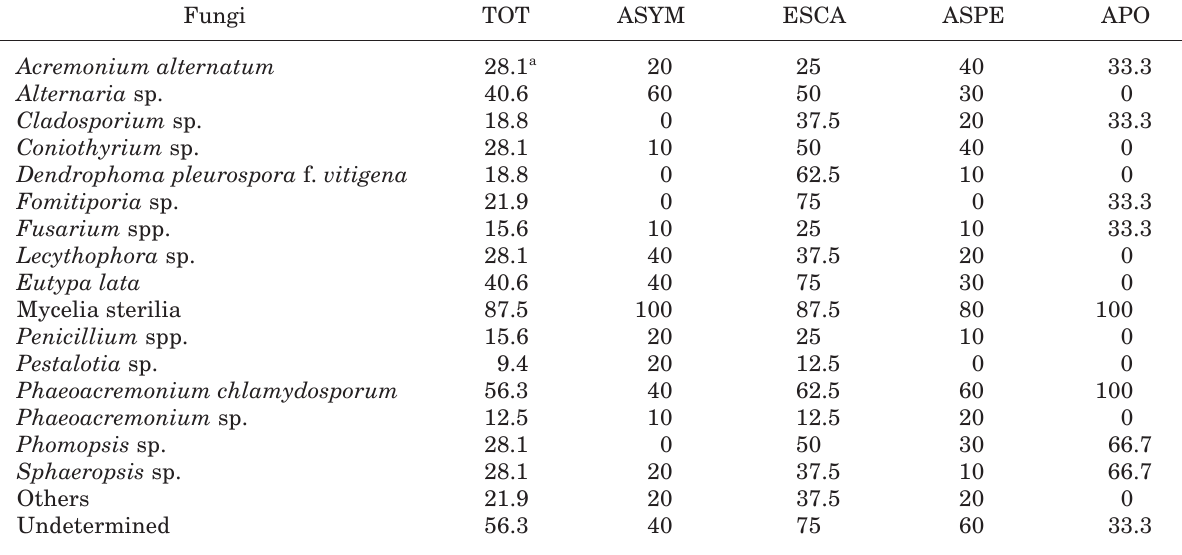
Table 2. Percentage of grapevine, showing or not showing foliar symptoms, which harboured each of the listed fungi.